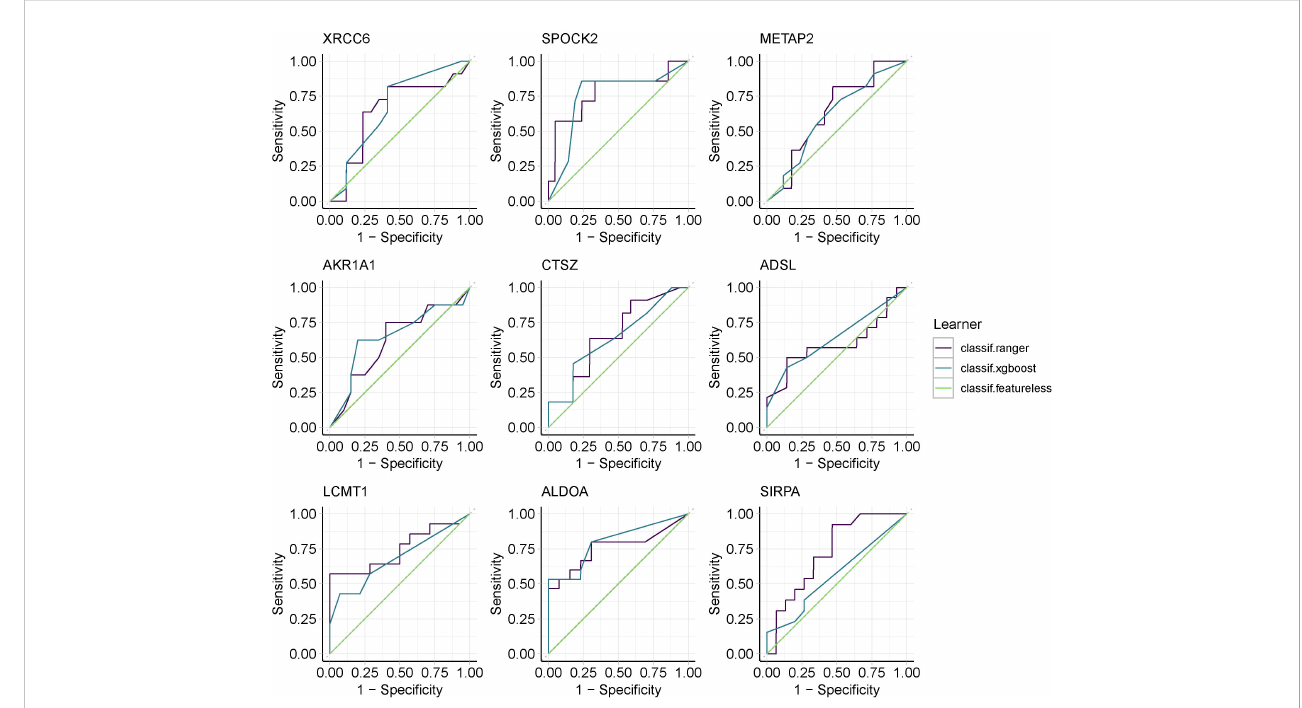
FIGURE 5 Machine learning screens for co-expressed genes with diagnostic validity,using Random Forest and